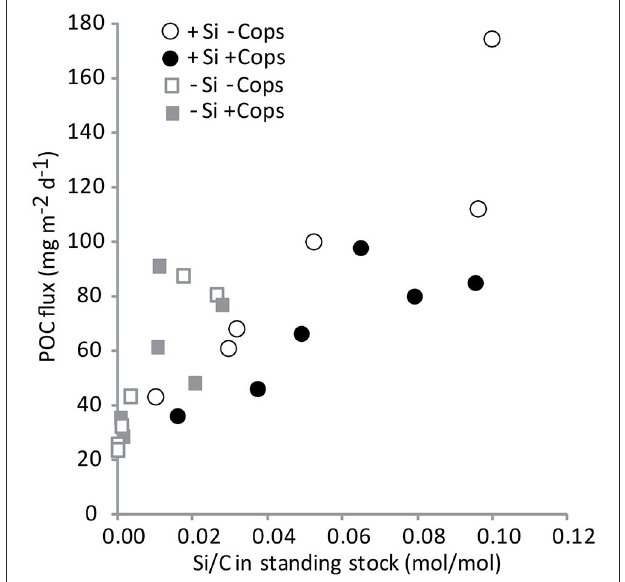
FIGURE 9 | POC fluxes versus Si/C ratios in the standing stocks in the upper 4.5m.